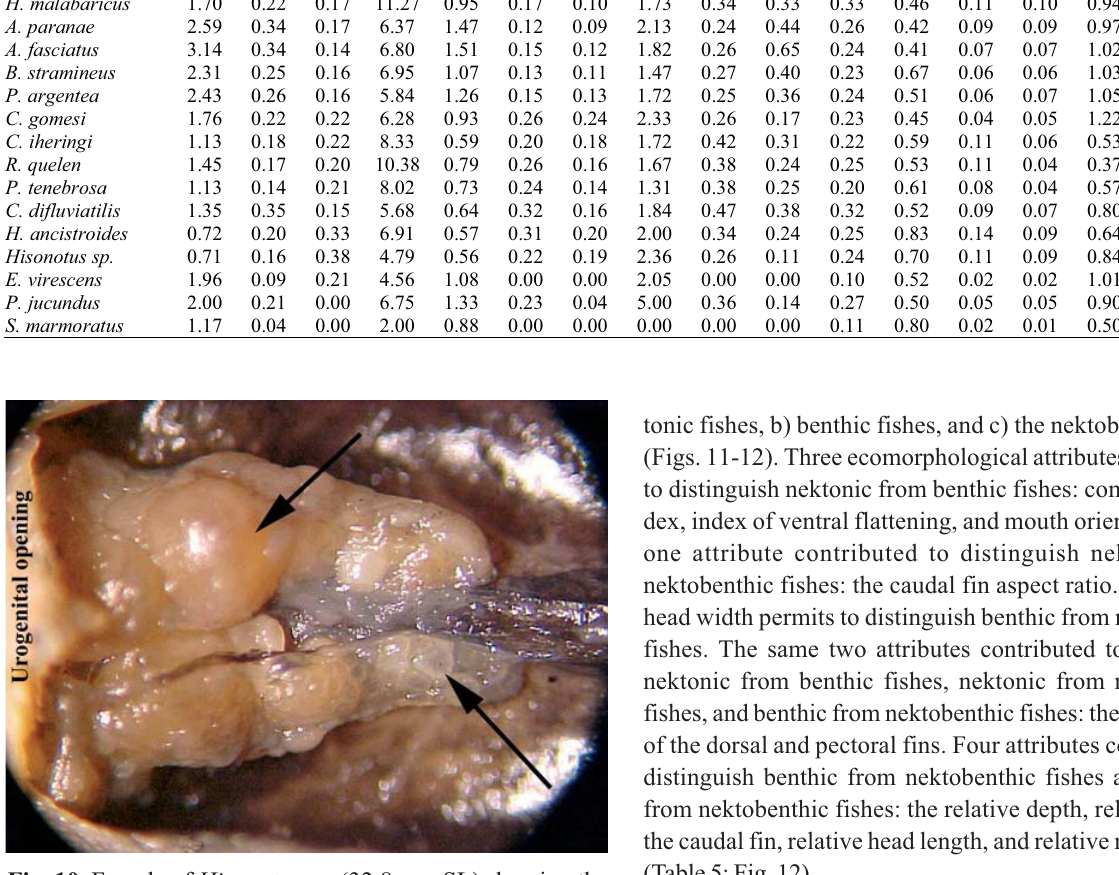
different stages of the oocytes maturation inside the ovary.